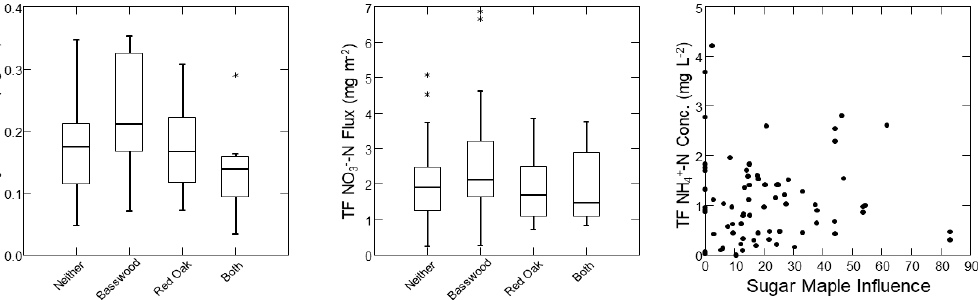
Figure 4. Visualization of significant species’ effects on throughfall N from the mixed-effects model. Asterisks (*) indicate outliers. Influence of basswood and red oak is shown with box-whisker plots showing TF NO 3 − concentration and fluxes for collectors that had a basswood tree within 8 m, red oak within 8 m, neither species within 8 m, nor both species within 8 m. The influence of sugar maple is visualized as a scatter plot of TF NH 4+ concentrations against sugar maple influence.